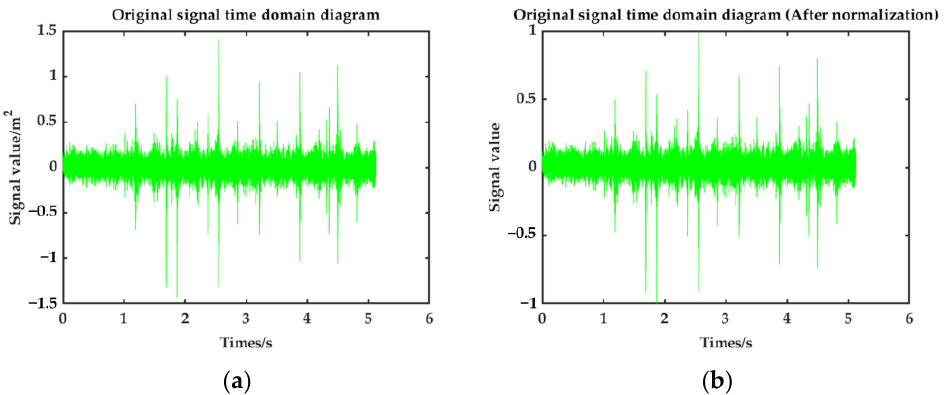
Figure 4. Data pre-processing before training: ( a ) Original signal; ( b ) normalized